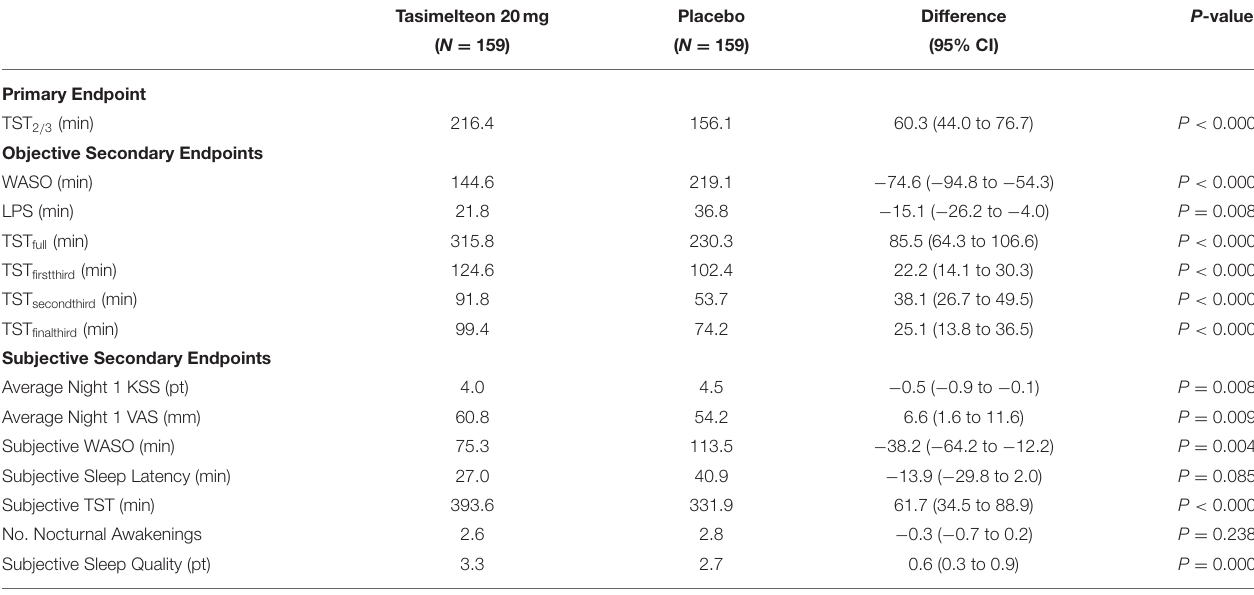
TABLE 2 | Summary of endpoints for the ITT population.